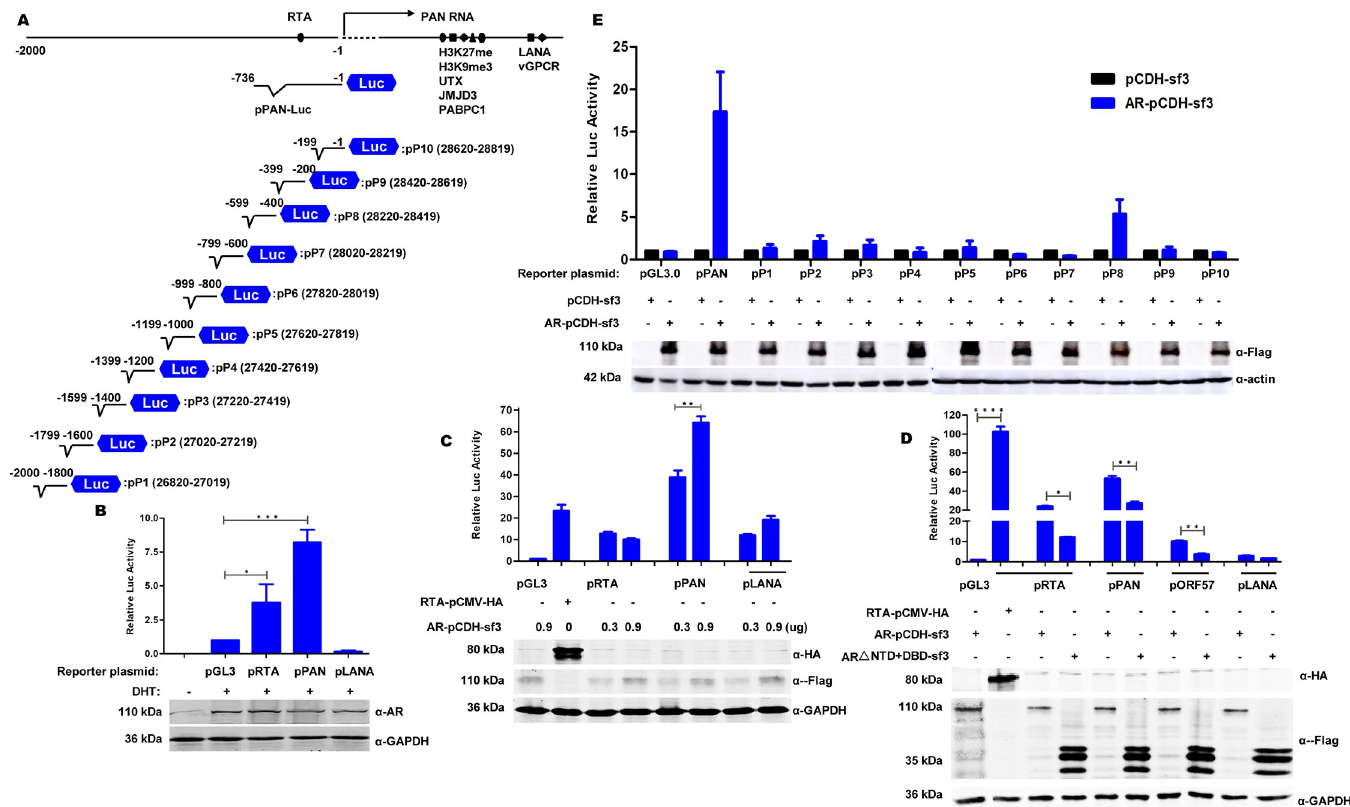
Fig 5. AR enhanced the promoter activity of PAN and RTA and acted as a canonical transcription factor. (A) Schematic illustration of common host and viral factors binding to PAN promoter and RNA transcript. The 10 deletion mutants of pP1 to pP10, which spanned to position –2000 bp from the transcriptional start site of PAN promoter by ~200-bp intervals. (B) DHT enhanced the promoter activity of KSHV lytic genes, especially for PAN. 293T cells were treated with DHT or MeOH for 24 h prior to transfection with corresponding reporter plasmids or pGL 3.0 vector. Empty vectors treated with DHT were used to balance the total amounts of plasmids in each group. Promoter activity was normalized by TK and presented as the fold relative to the vector control. (C) Ectopic AR transactivated the promoter of PAN in a dose-dependent manner. 293T cells were transfected with fixed amounts of dual-reporter plasmids and increasing amounts of full-length AR-expressing plasmid, as indicated. Promoter activity was compared with that of vector control by AR overexpression at a lower dose. (D) Transactivating domain of AR was necessarily required for PAN activity. The full-length AR-expressing plasmid or N-terminus with DNA-binding domain-deleted mutant was co-transfected with an individual reporter plasmid in 293T cells. The promoter activity was compared with that of pGL3.0 vector control co-transfected with full-length AR-expressing plasmid. (E) Fine mapping of PAN promoter using 10 truncation plasmids verified that the sequence from 28,220 to 28,419 bp was critical for AR transactivation. The plasmids in (A) were co- transfected into 293T cells with full-length AR-expressing plasmid or the vector for 36 h. The promoter activity was compared with that of a pCDH-sf3 vector with an AR-expressing plasmid. All results were normalized by TK. The protein levels of full-length AR, the mutant ( α -Flag), and positive control of RTA ( α -HA) were determined by Western blotting, using GAPDH as the loading control. n.s., not significant; � P < 0.05; �� P < 0.01; ��� P < 0.001. Only the significant P value was indicated in the panel. Representative images are shown. Each reaction was repeated in, at least,